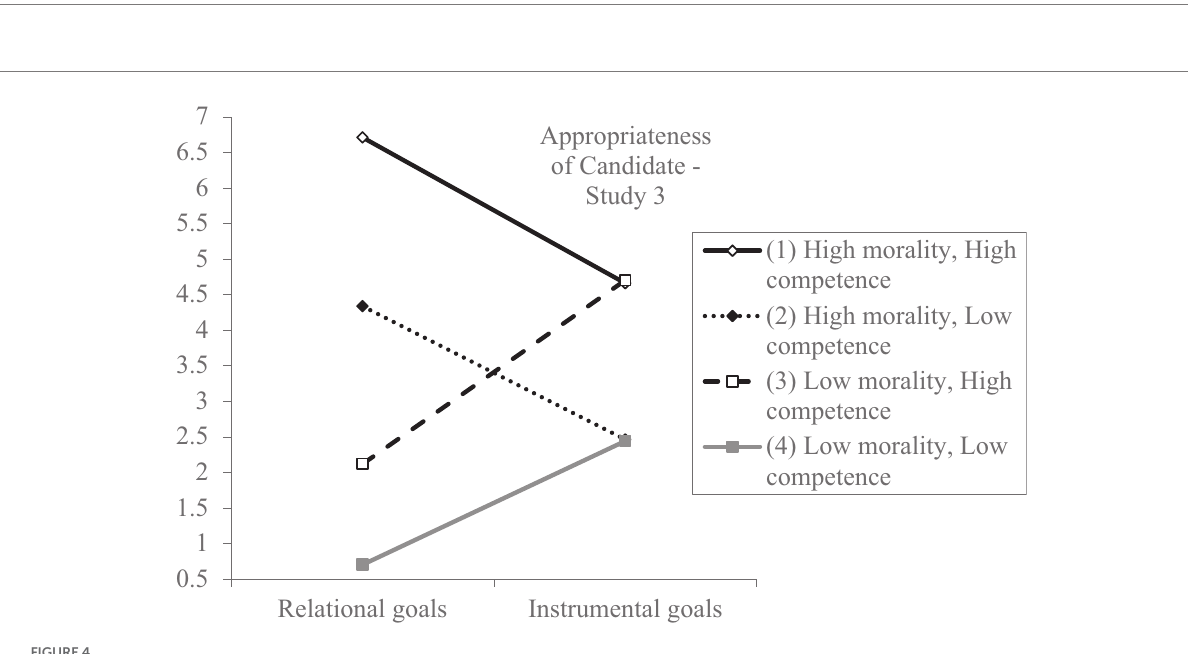
FIGURE 4 Perceived appropriateness of a candidate as a function of type of goals, morality, and competence (Study 3). Ratings were on a 7-point scale (1 = not at all , 7 = to a great extent ). Error bars represent standard